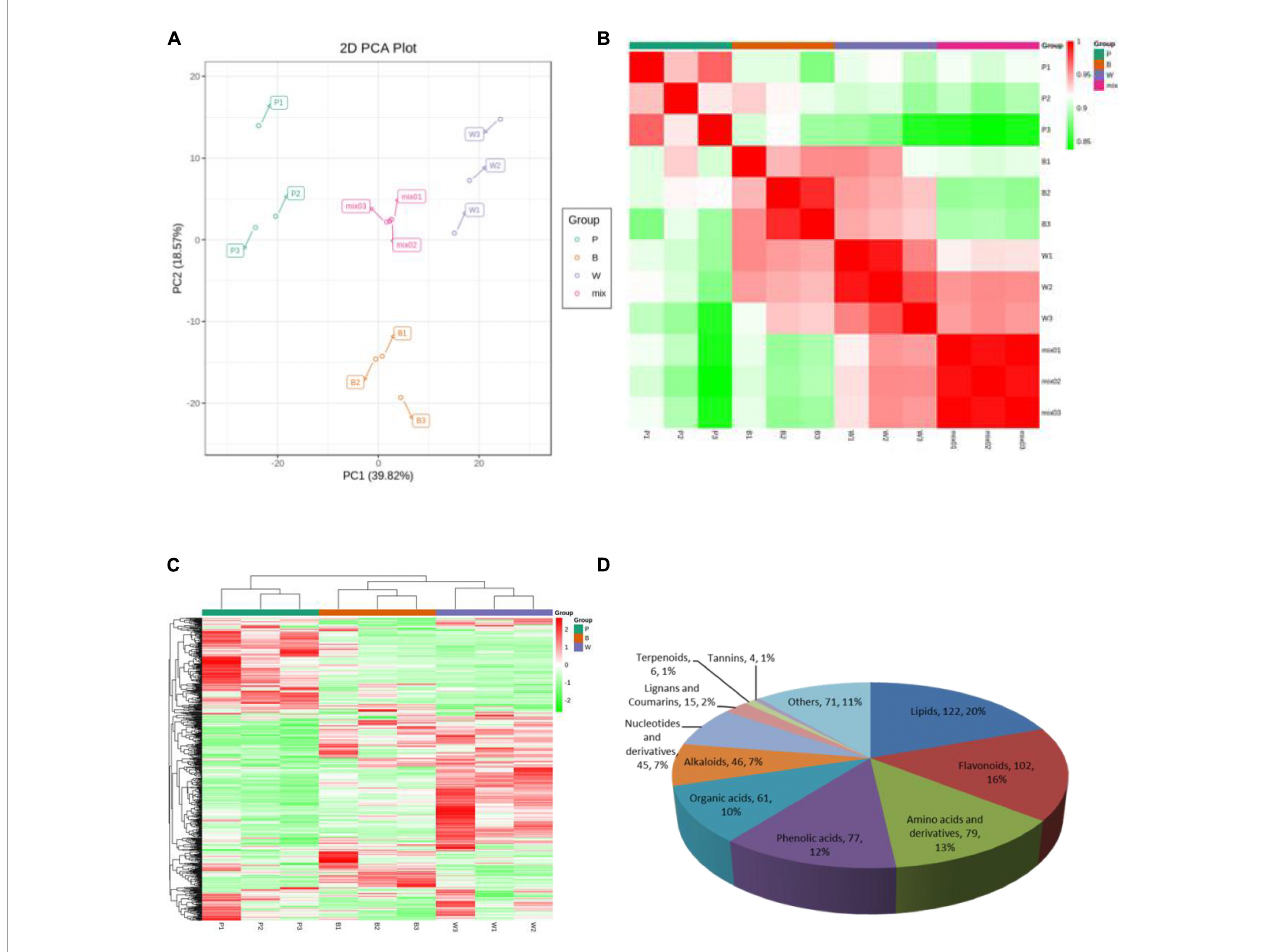
FIGURE2 Mass spectrometry data of quality control wheat samples. (A) Principal component analysis (PCA) score map, where “mix” represents a mix of three lines. (B) Correlation map among samples. The horizontal coordinate of the correlation graph between samples indicates the sample name, the vertical coordinate indicates the corresponding sample name, and the color represents the correlation coefficient value. (C) Overall cluster diagram of samples. In the overall clustering plot, the sample name is presented in the horizontal coordinate, the metabolite information is presented in the vertical coordinate, where “Group” represents each group, “Class” represents the substance classification, and red represents high content, green represents low content. (D) Classification map of 628